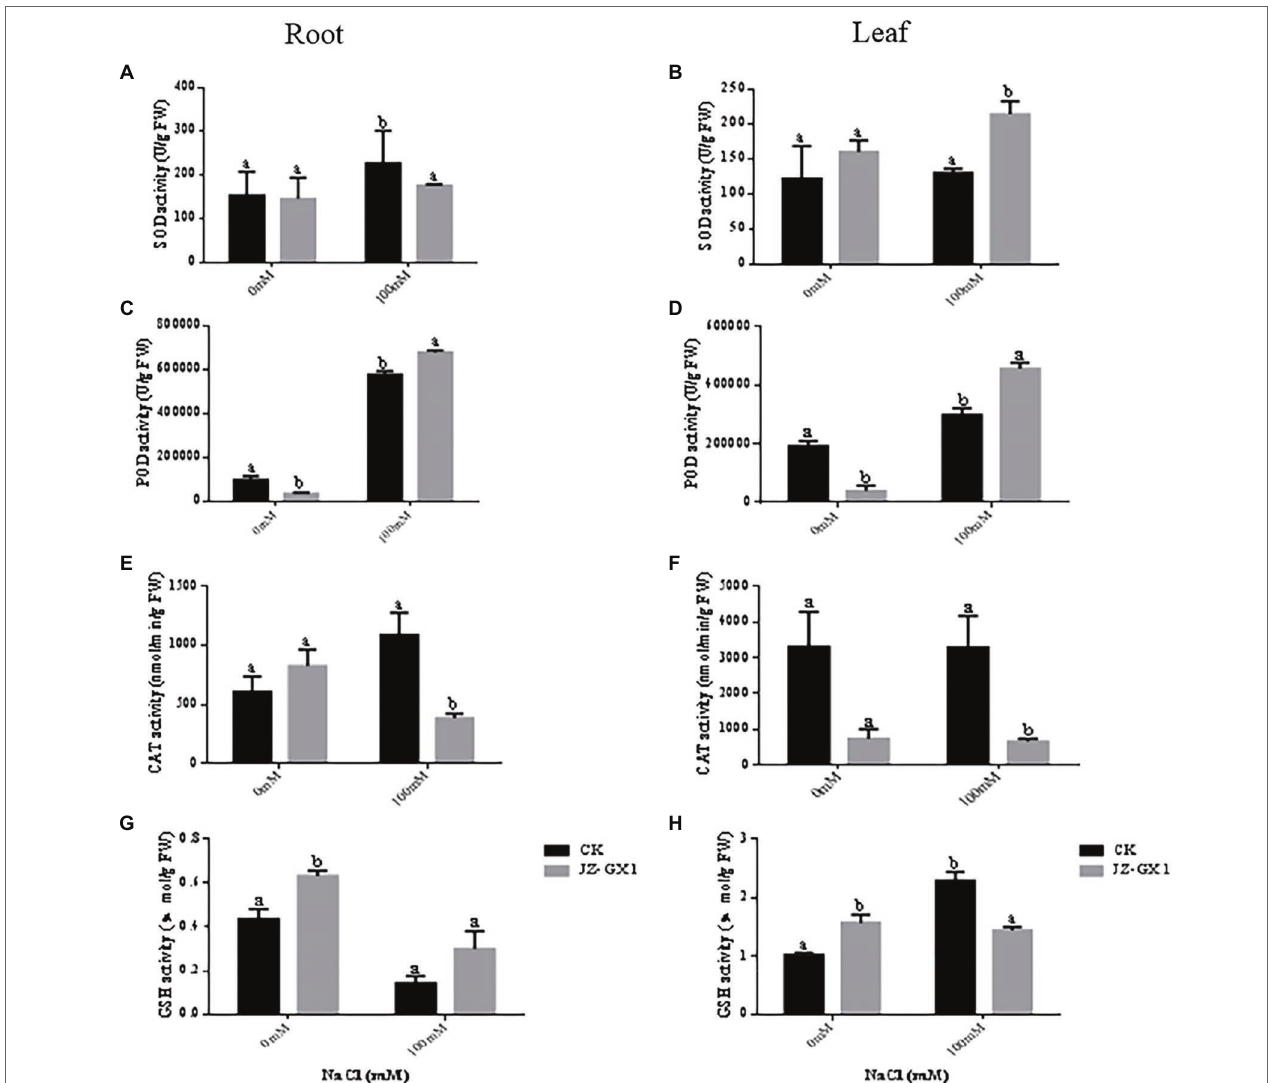
FIGURE 7 | Effect of volatile gases produced by R. aquatilis JZ-GX1 on the superoxide dismutase (SOD), peroxidase (POD), CAT and glutathione reductase (GSH) activities in the leaves and roots of R. pseudoacacia . (A) Root SOD activity; (B) leaf SOD activity; (C) root POD activity; (D) leaf POD activity; (E) root CAT activity; (F) leaf CAT activity; (G) root GSH activity; (H) leaf GSH